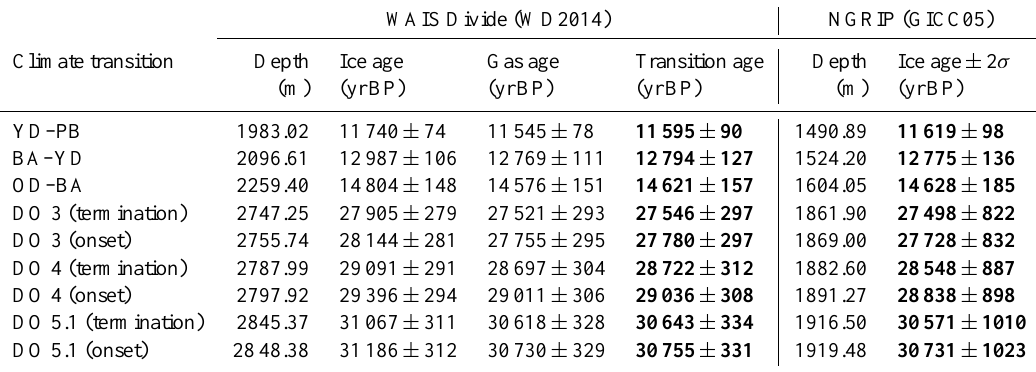
Table 4. Comparison to the independent ice core chronology GICC05 from NGRIP (Andersen et al., 2006; Rasmussen et al., 2006; Svensson et al., 2006). To calculate from WD2014 ages for rapid climate transitions (transition ages; bold) in Greenland (i.e. δ 18 O), we use a Greenland- CH 4 phasing of 50 ± 30 years for the Younger Dryas–Preboreal (YD–PB) transition, 45 ± 30 years for the Older Dryas to Bølling–Allerød (OD–BA) transition and 25 ± 30 years for all other transitions (Rosen et al., 2014; Buizert et al., 2015). A detailed description and discussion for the WAIS Divide (cid:49) age estimation and synchronization procedures between the WAIS Divide CH 4 record and NGRIP δ 18 O is provided by Buizert et al. (2015) and in the